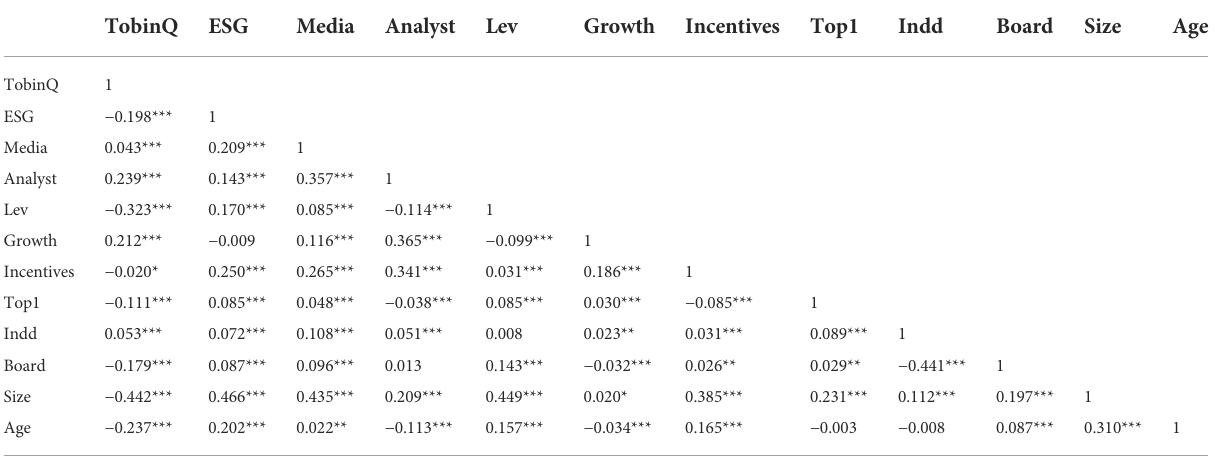
TABLE 3 Correlation matrix.